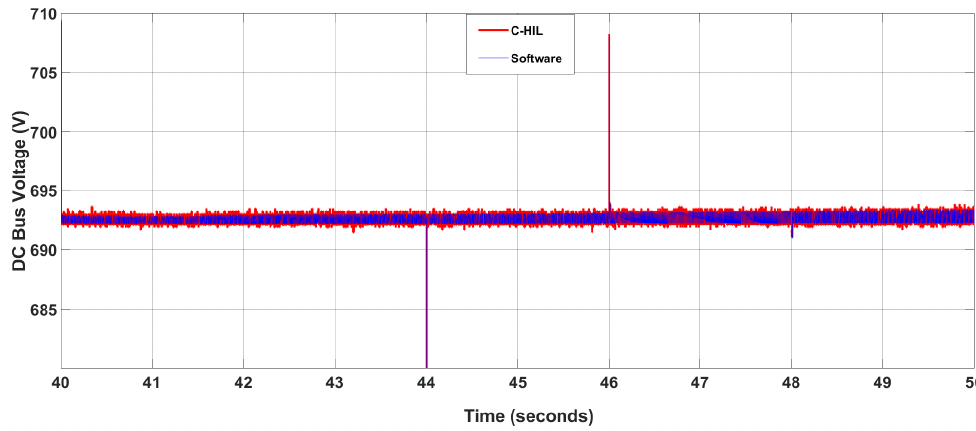
Figure 19. HIL DC bus voltage regulation under constant load.